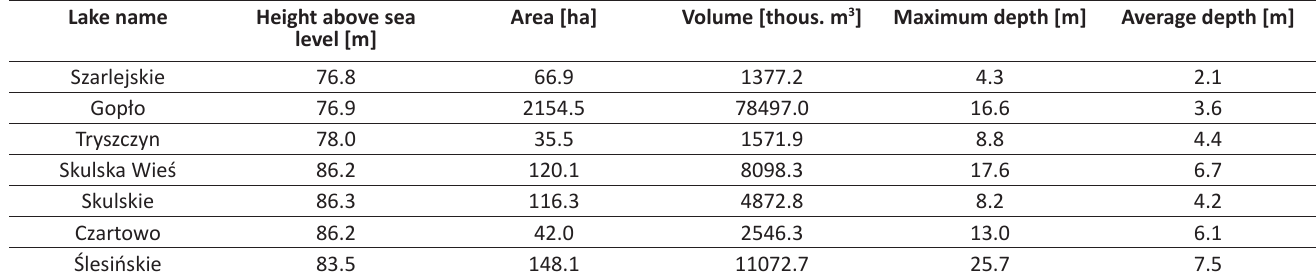
Table 1 . Summary of basic morphometric parameters of